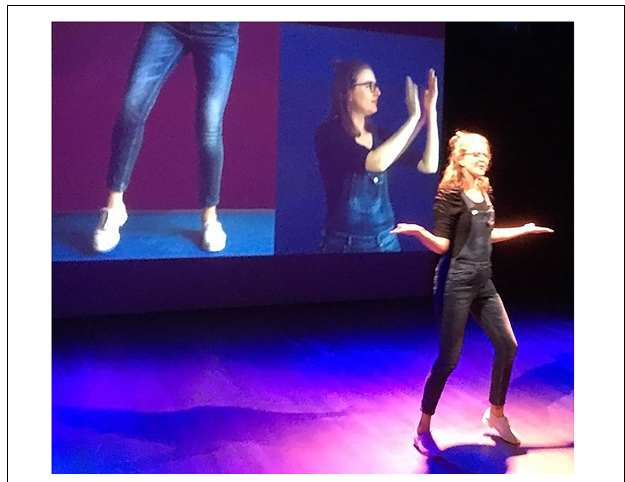
FIGURE 3 | Embodied rhythms—pervasive musical rhythms are indicated through foot taps and hand claps projected on a screen behind the performer (Francie Manhardt—reproduced with